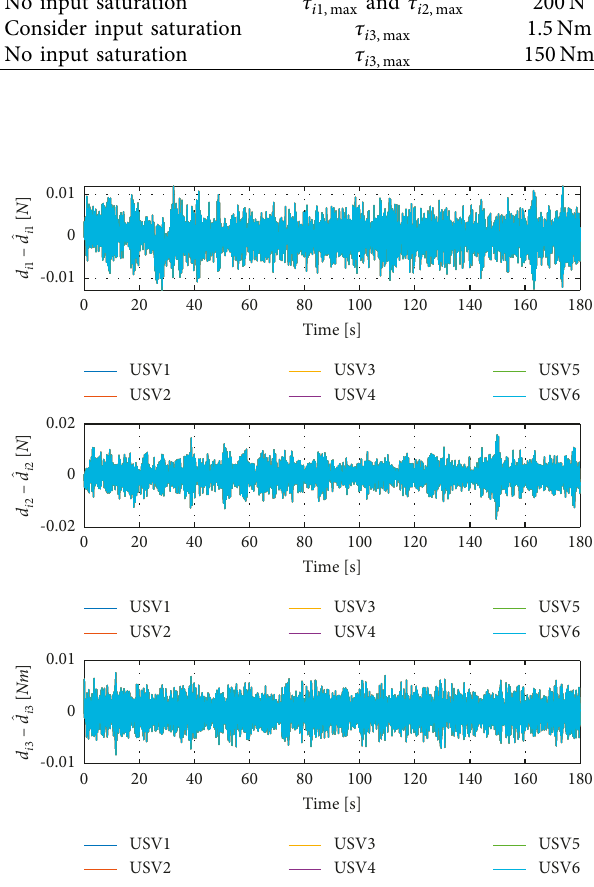
Figure 9: The disturbance error ( 􏽥 d